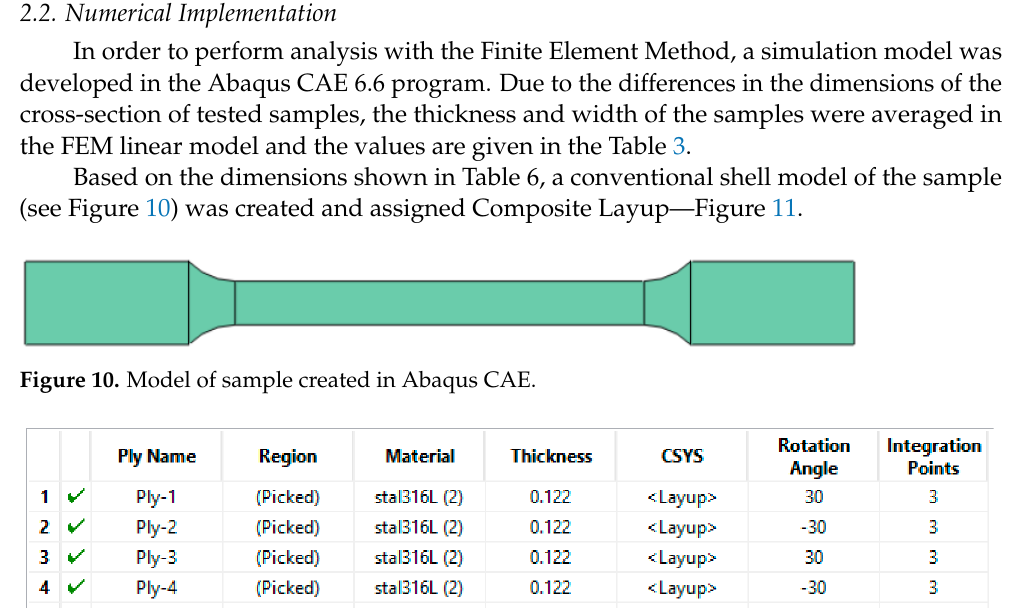
Figure 11. Part of Composite Layup assigned to the model.